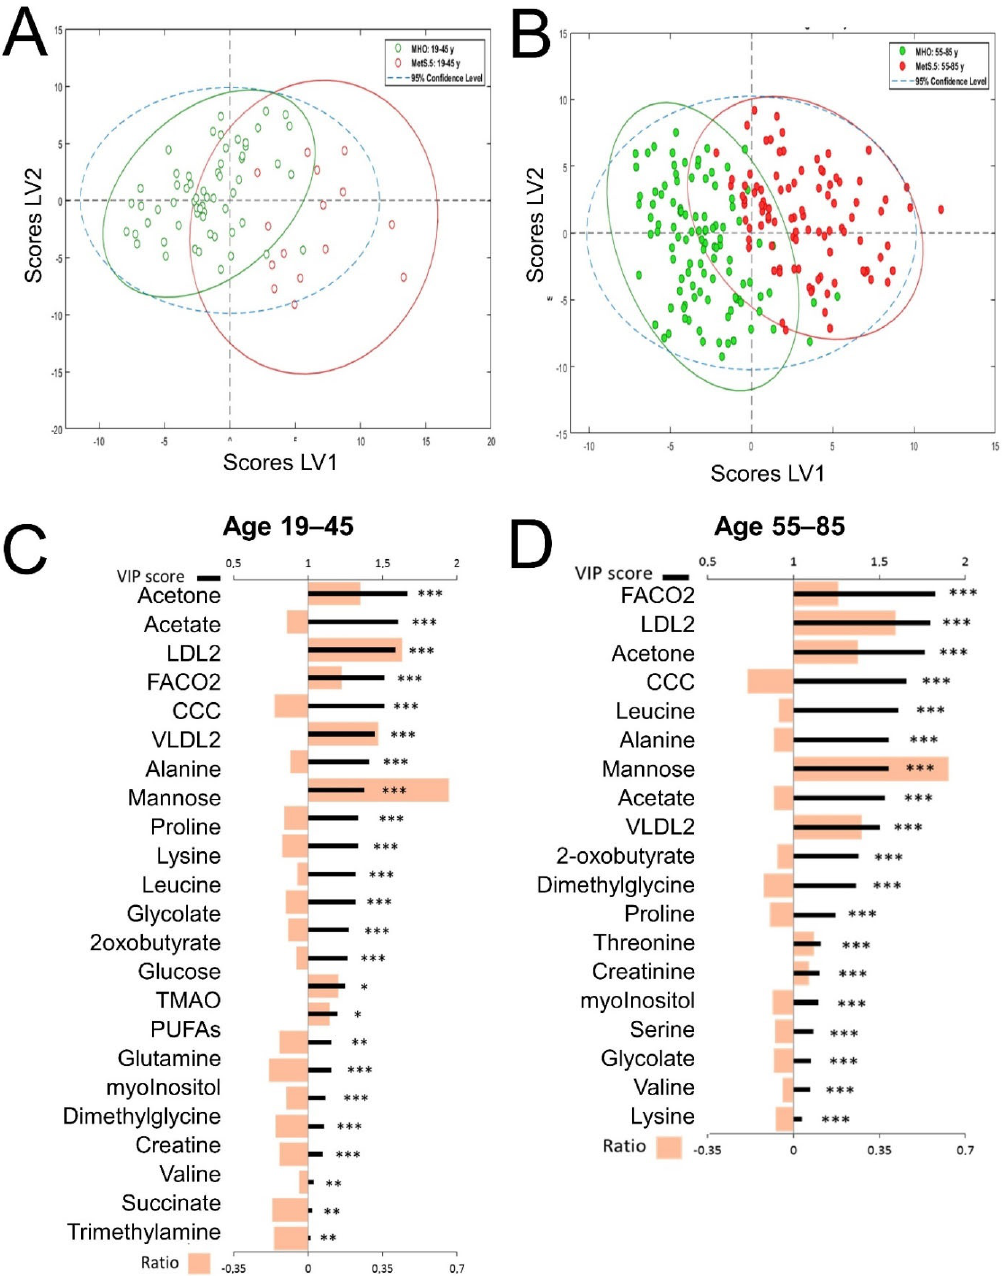
Figure 3. PLS-DA model for discrimination between MetS.5 and MHO by age range for women. All models were built using 2 latent variables (LV). All scores plots show MetS.5 samples in red and MHO samples in green with 95% confidence ellipse in the same colors. VIPs scores are represented as thick black lines (scale on the top) and relative fold change calculated as (Metabolite mean concentration of Mets.5—Metabolite mean concentration of MHO)/Metabolite mean concentration of MHO, are represented by grey bars (scale on the bottom). Significant alterations are indicated by *. Adjusted p -values (Student’s t -test corrected by Bonferroni method) to 0.00091 (*), 0.00018 (**), 0.000018 (***). ( A ). Scores plot for the age range 19 to 45 years model. Cross-validation parameters: RMSECV 0.273, R2CV: 0.534; ROC Curve AUC: 0.97. ( B ). Scores plot for the age range 55 to 85 years model. Cross-validation parameters: RMSECV 0.298 R2CV: 0.642; ROC Curve AUC: 0.98. ( C ). VIP score and relative fold change bar plot for the age range 19 to 45 years model. ( D ). VIP score and relative fold change bar plot for the age range 55 to 85 years